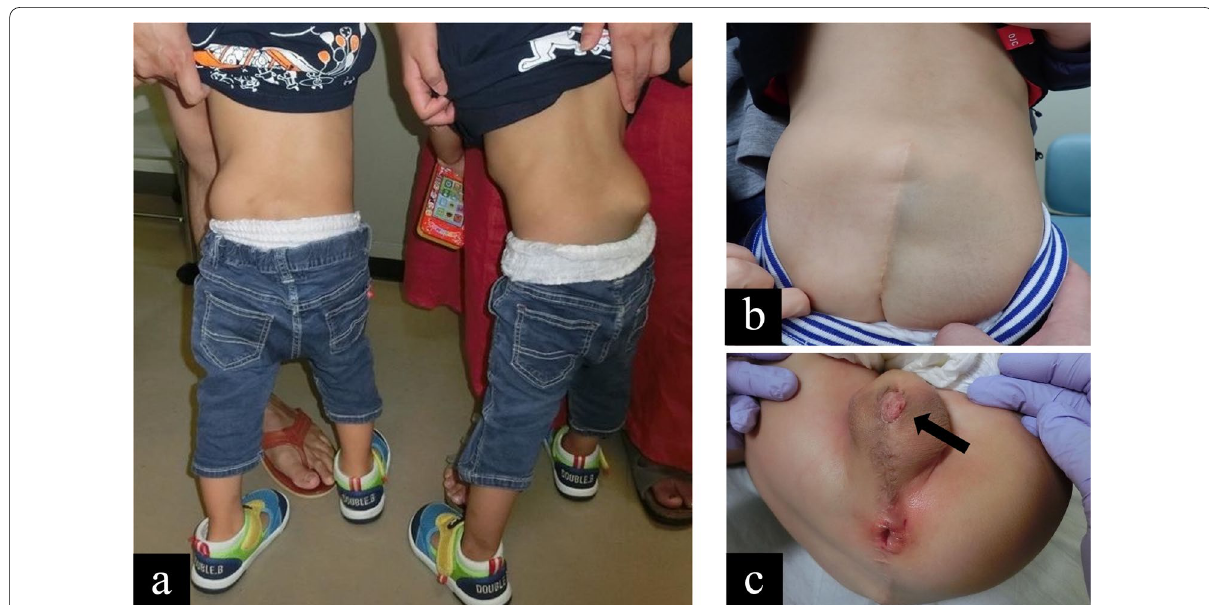
Fig. 4 General appearance after separation of the pygopagus patient. Follow-up physical examination: a the patients stand by themselves. b Their scars are clear, and c external urethral orifice (arrow) and anal aperture are shown